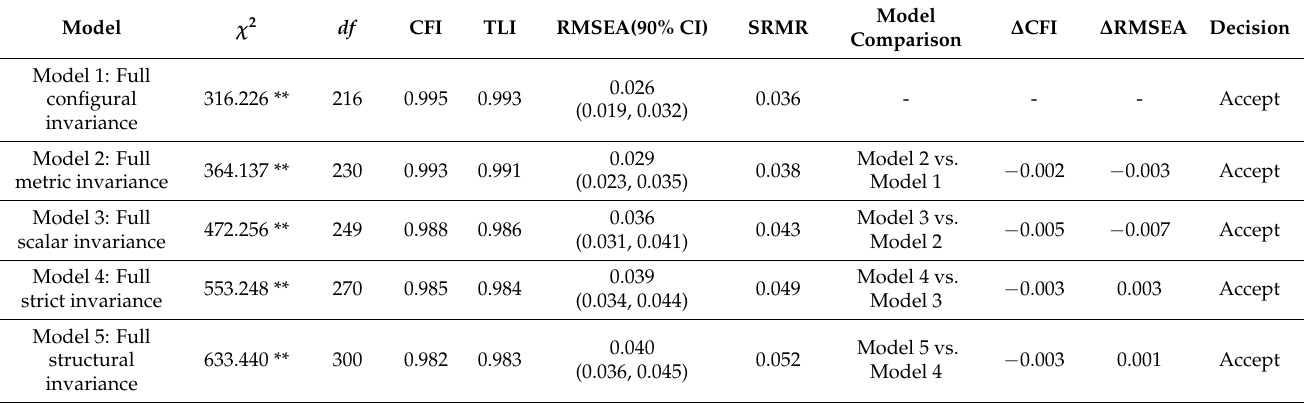
Table 3. Factor loadings and regression coefficients of the model explaining COVID-19 vaccination